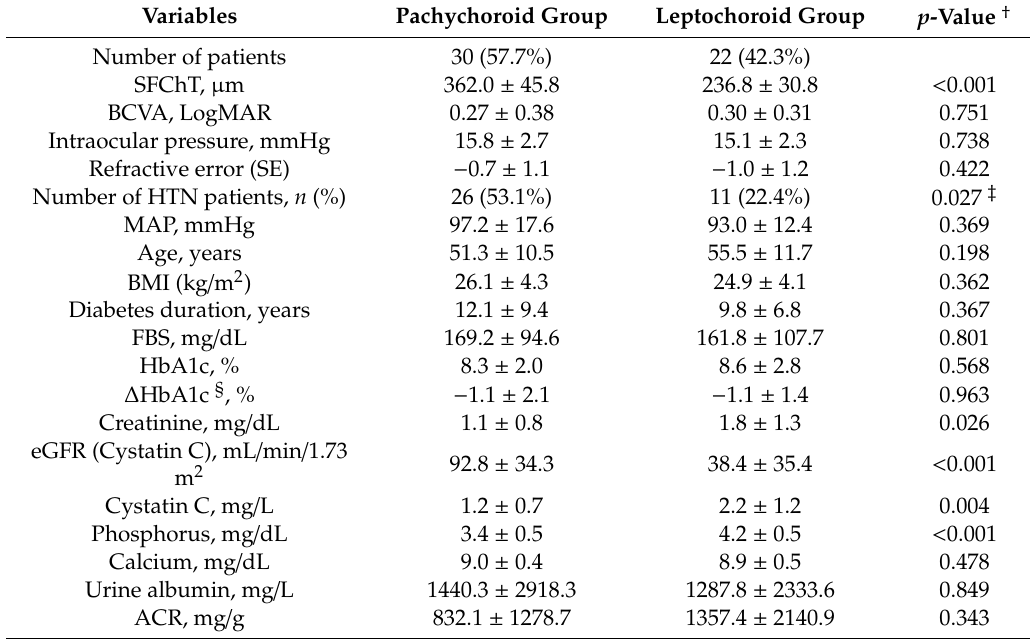
Table 2. Comparison of the clinical characteristics and kidney parameters of diabetes mellitus patients with treatment-naïve proliferative diabetic retinopathy according to subfoveal choroidal